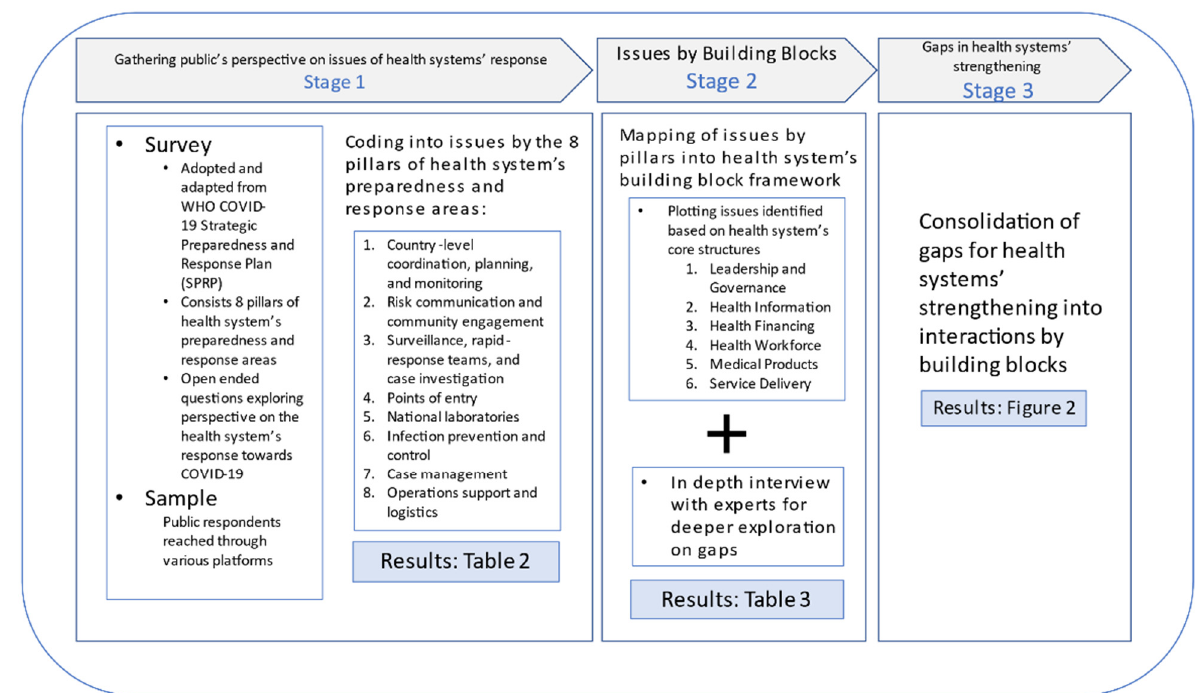
Figure 1. Summary of study flow based on the three stages.